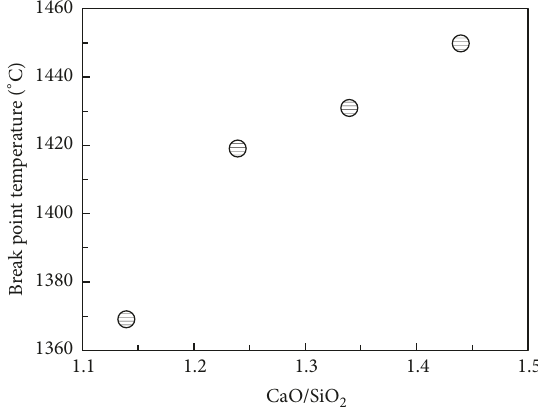
Figure 2: Break point temperature for slag series R and basic